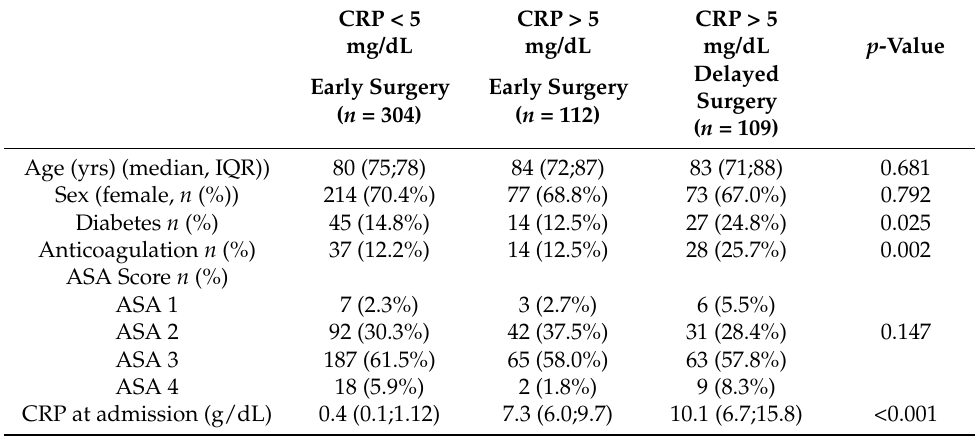
Table 2. Demographic data of the groups.